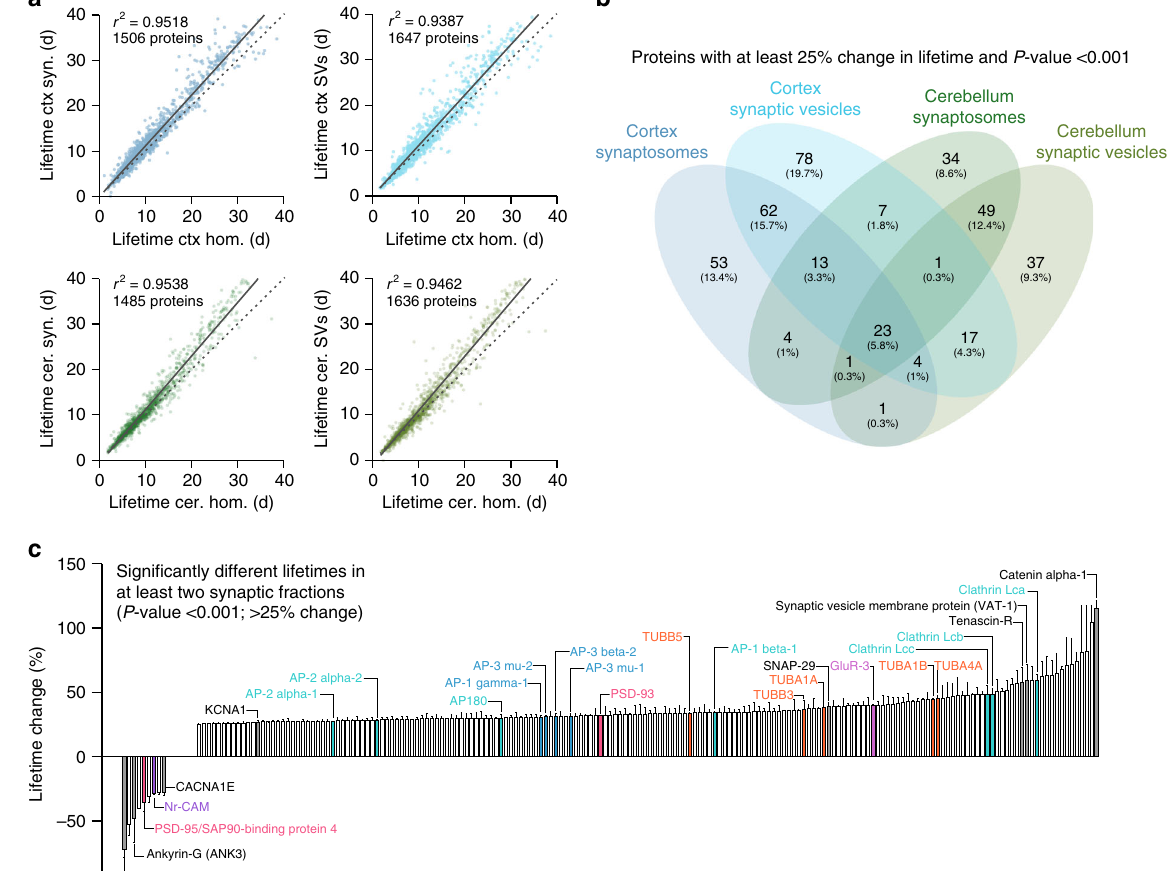
Fig. 6 Protein lifetime changes in the synaptic fractions. a Scatter plots of protein lifetimes between the homogenate and either the synaptosomal or the synaptic vesicle (SV) fractions. The blue plots represent data obtained from the cortex, while the green plots correspond to the cerebellum. In all cases, synaptic-enriched fractions are longer lived, as indicated by the upward trend vs. the diagonal identity line (represented as a segmented trait). All lifetimes are reported with their con fi dence intervals in Supplementary Data 1. b Venn diagrams showing the overlap of proteins signi fi cantly changed in the four datasets (25% change with Bonferroni adjusted P -values < 0.001). While some proteins change speci fi cally in only one dataset, there are many proteins that changed in the same manner across different datasets. c Average lifetime changes in the synaptic fractions (only shown for proteins signi fi cantly different in at least two of the four fractions, with a change >25% and P -value < 0.001). A positive change indicates longer lifetimes in the synaptic fractions. In accordance to the scatter plots, the majority of lifetimes are increased in the synaptic fractions. Synaptic molecules already discussed in Fig. 2 are detailed and color-coded as in Fig. 3b. Several exo-endocytosis cofactors (turquoise) are stabilized, together with AP-1/3 adaptor proteins (light blue). Several tubulin subunits are stabilized (orange), as well as GluR-3. A number of other synaptic components are indicated in black. In general there is a clear differential regulation of adhesion molecules, with some either stabilized or destabilized at the synapse, suggesting that their localization might be a predominant determinant of their stability. See also Supplementary Fig. 21c-f for the detailed gene ontology analysis of the lifetime changes among different